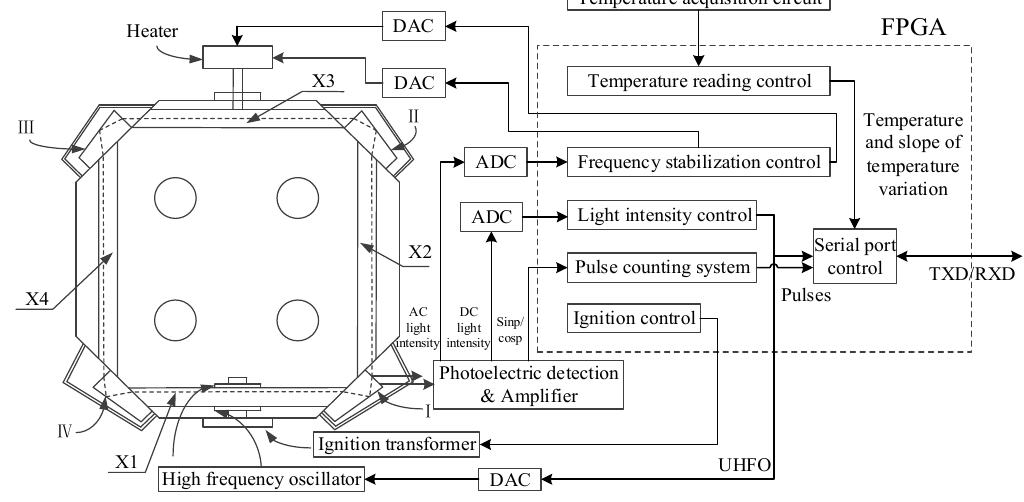
Figure 1. Basic block diagram of TRPLG (total reflection prism laser gyro).